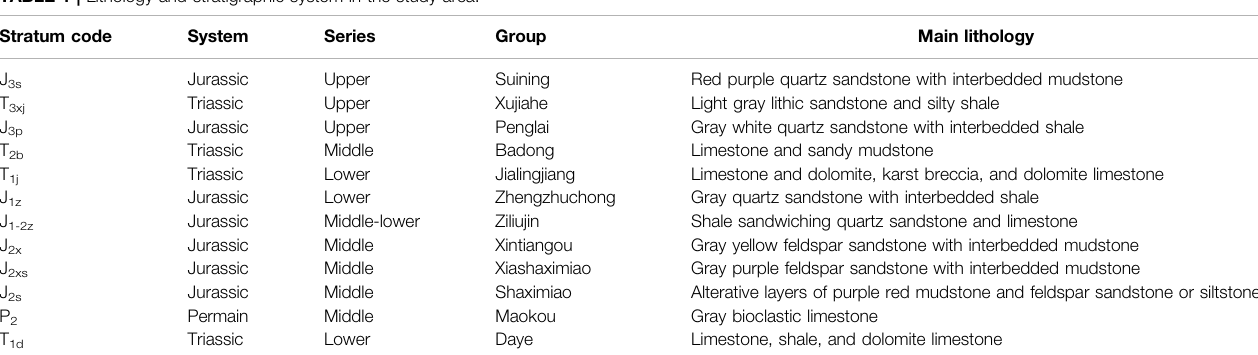
TABLE 1 | Lithology and stratigraphic system in the study